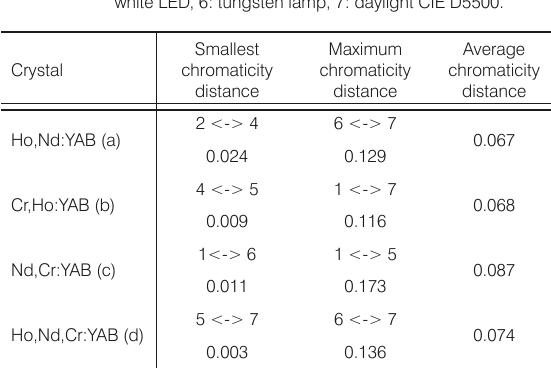
Table 4. Comparison of the three crystal types: maximum, minimum and average chromaticity differences. 1: fl. lamp type 32,